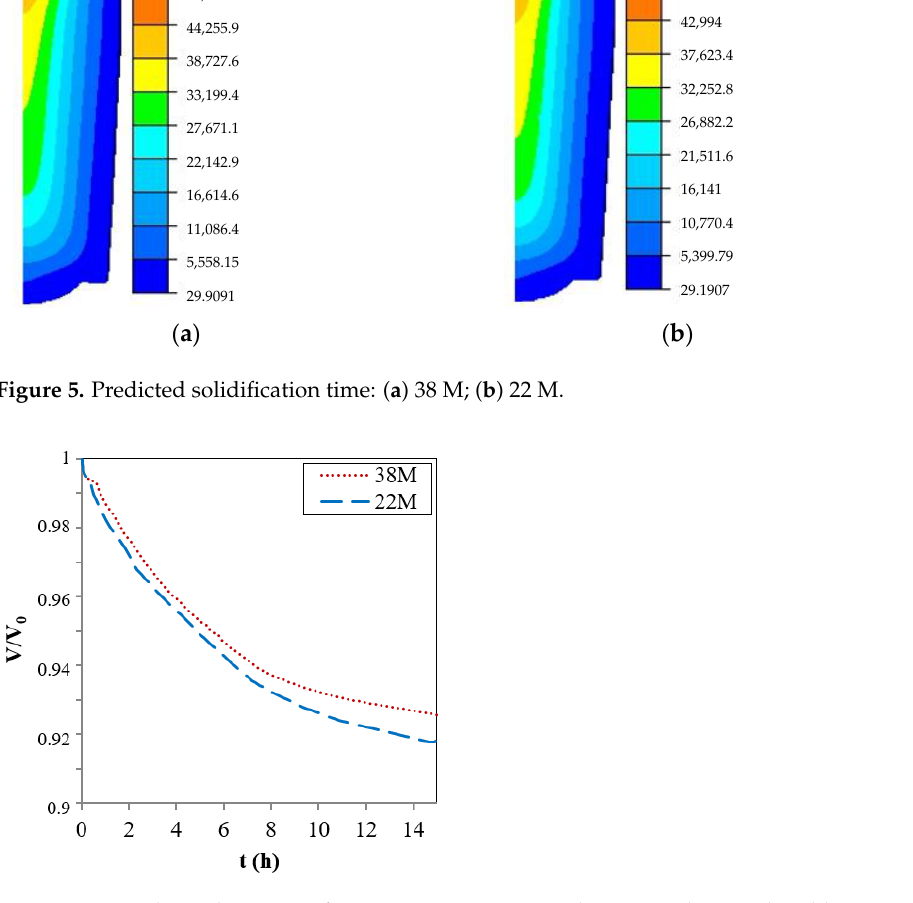
Figure 6. Time-dependent ratio of instantaneous casting volume V to the initial mold vacant one V 0 .